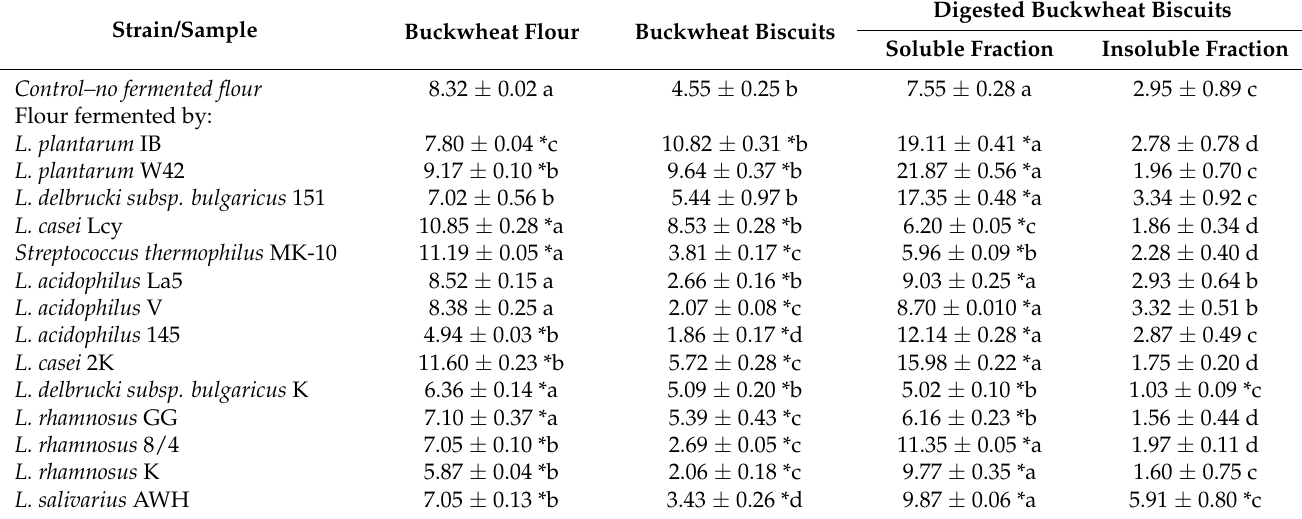
Table 3. The content of quercetin (Q) in fermented raw buckwheat flours and buckwheat biscuits before and after digestion in vitro ( µ g g − 1 d.m.).